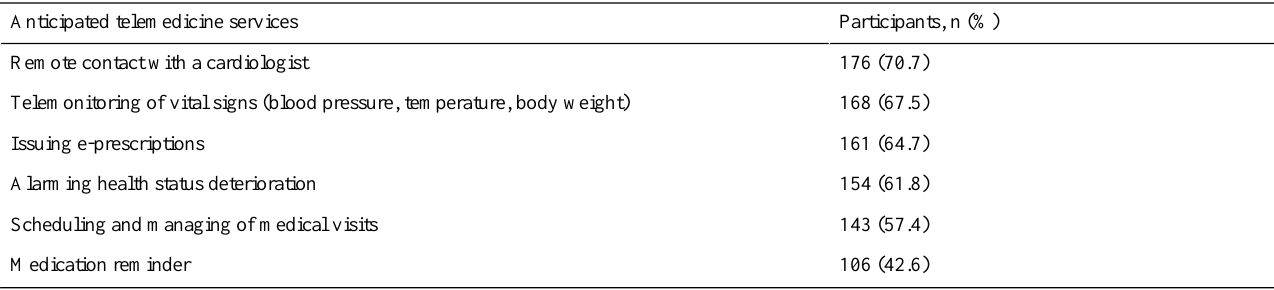
Table 2. Patients' readiness for telemedicine solutions.